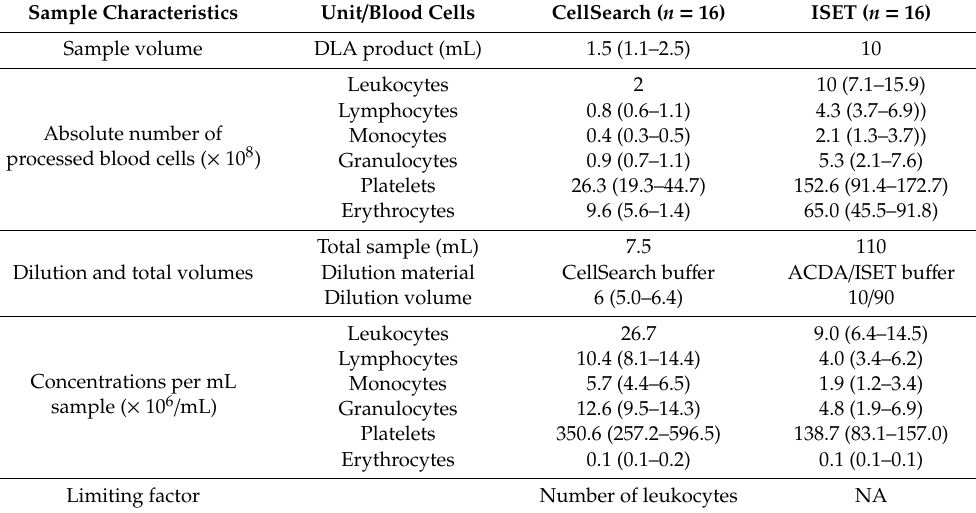
Table 1. Sample and dilution volumes with cell counts processed by CellSearch and ISET for CTC enumeration.